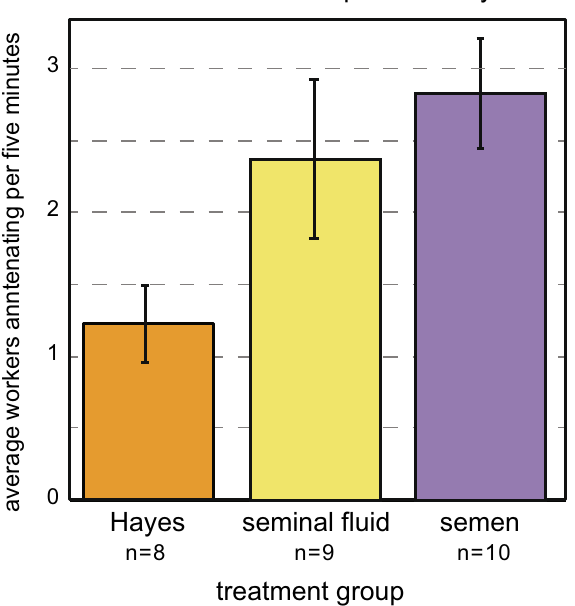
Figure 3. Worker retinue response assay. Workers were more attracted to both seminal fluid- and semen- injected queens compared to Hayes-injected queens (Pairwise t-tests; Bonferroni adj. p-values = 0.049, 0.019). Error bars represent standard error of the